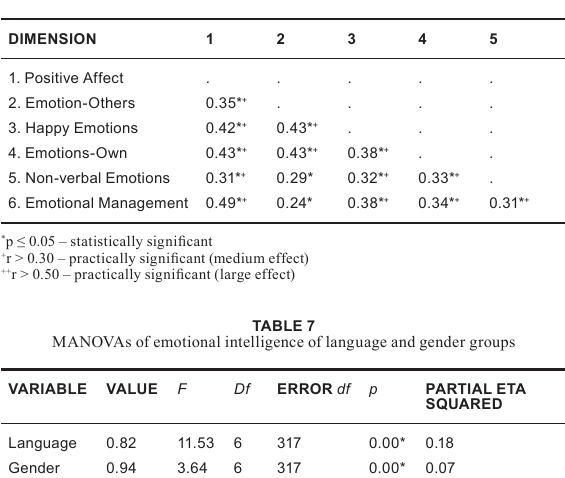
table 6 Product-moment correlation coefficients between the SEIS dimensions